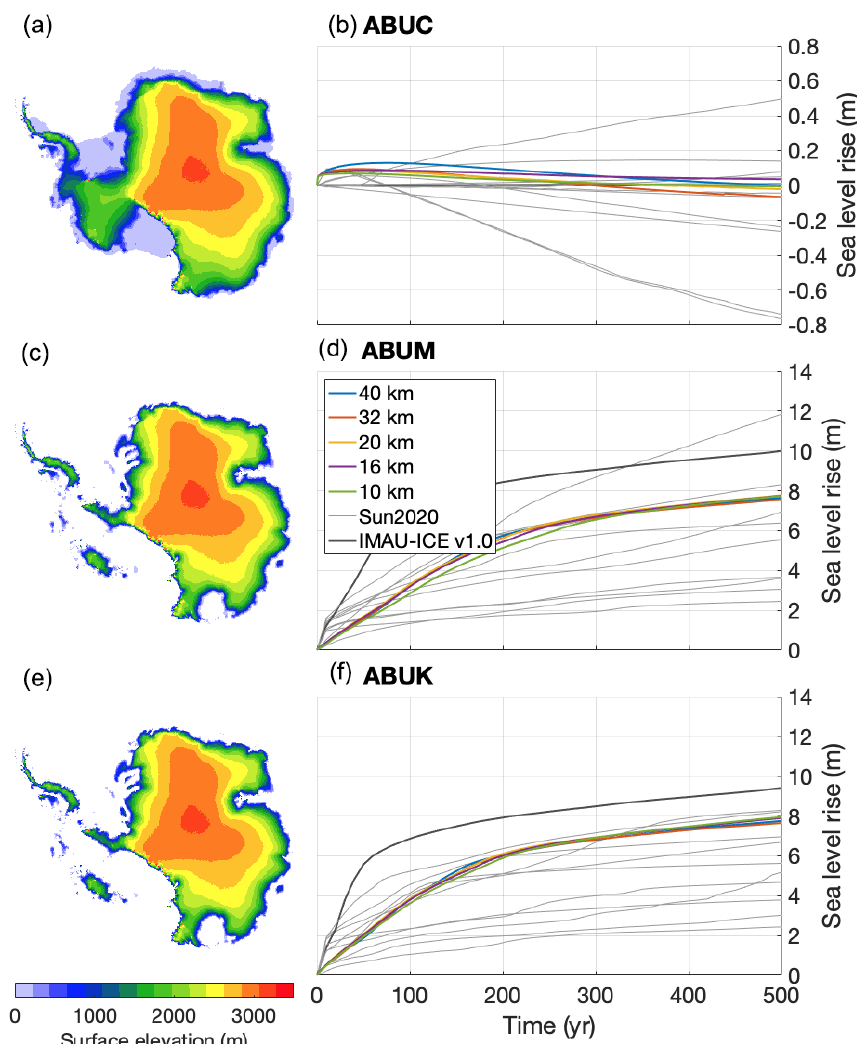
Figure 9. Surface elevation after 500 model years (a, c, e) and sea-level rise over time (b, d, f) at different model resolutions in the ABUMIP experiments. Grey lines indicate the results of the models that participated in the ABUMIP model comparison (Sun et al., 2020); the results from IMAU-ICE v1.0 (run at 32km, taken from Sun et al., 2020) are shown by the thick grey line. The panels on the left show results from the 10km experiments for IMAU-ICE v2.0 at t =